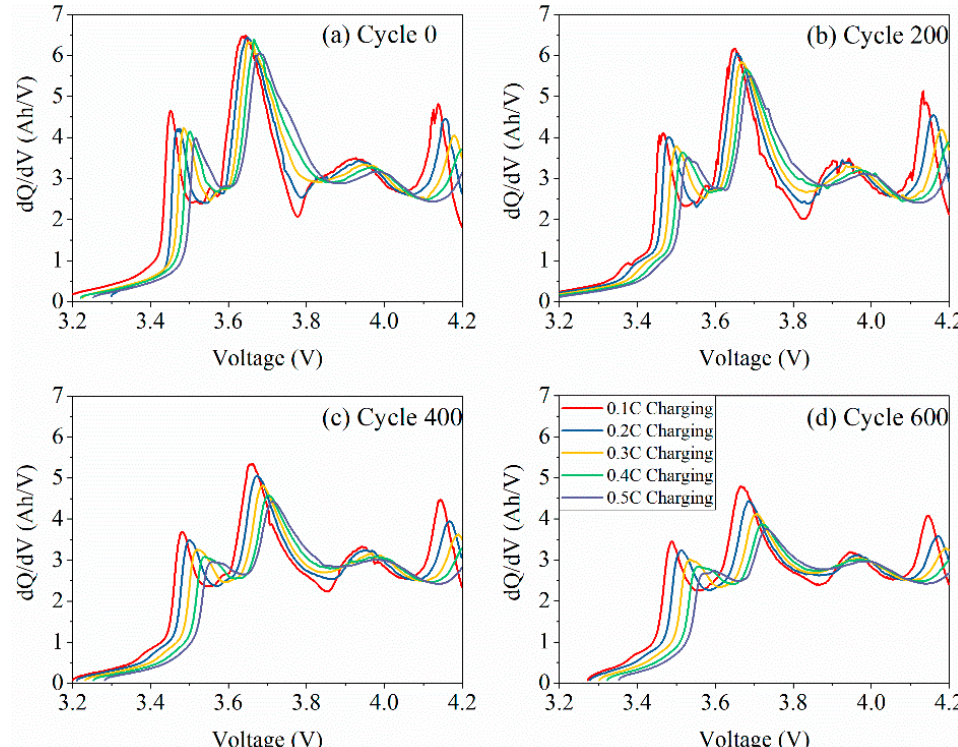
Figure 2. IC curves with different current rates under different aging cycles: ( a ) cycle 0; ( b ) cycle 200; ( c ) cycle 400; ( d ) cycle 600.